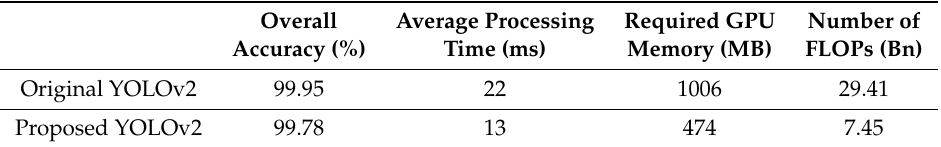
Table 5. Comparison of original YOLOv2 and proposed YOLOv2 model.